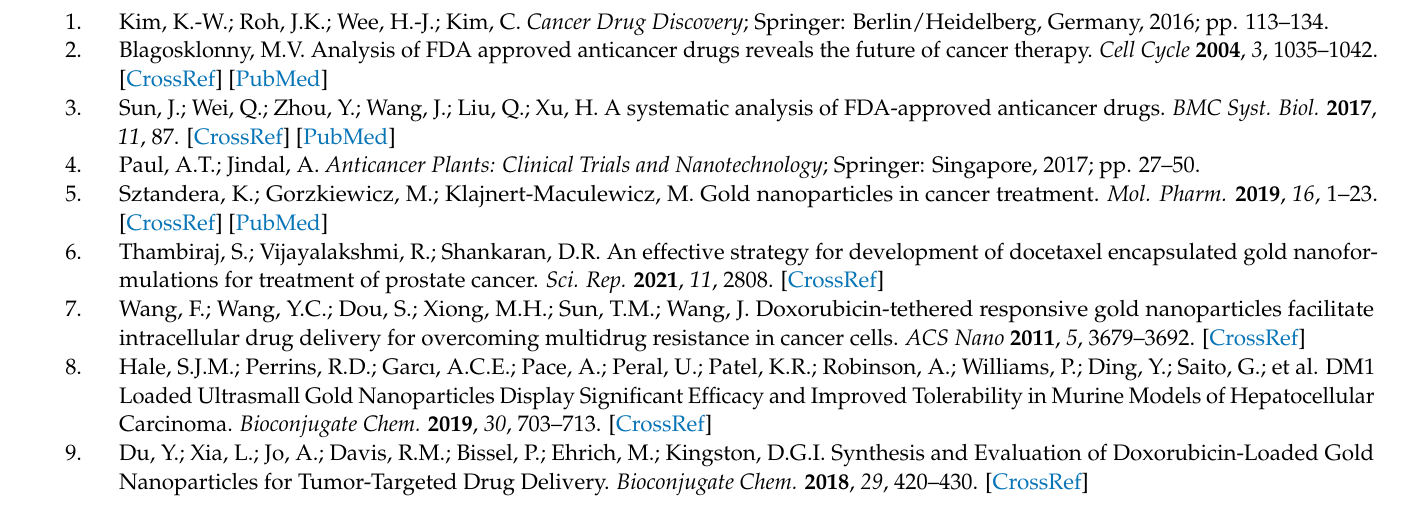
NMR data (DMSO- d 6 , 100 MHz) of Tsitsikammamine B ( 7 , TB) obtained at 298 K. Figure S5. 1 H NMR data (DMSO- d 6 , 400 MHz) of 14-bromodiscorhabdin C ( 5 , BDC) obtained at 298 K. Figure S6. 13 C NMR data (DMSO- d 6 , 100 MHz) of 14-bromodiscorhabdin C ( 5 , BDC) obtained at 298 K. Figure S7. 1 H- 13 C HSQC NMR data (400 MHz, D 2 O) obtained from the S. incisifolium aqueous extract. Figure S8. 1H DOSY spectra (400 MHz) of the S. incisifolium aqueous extract in D 2 O at 25 ◦ C. The values obtained in log(m 2 /s) for the polyphenol, polysaccharides and water signals are given on the spectrum. Figure S9. Typical UV/Visible spectra obtained for the AuNPs (A) synthesized using the S. incisifolium extract (1.0 mg and 20 mg of HAuCl 4 salt), with absorbance spectra collected every 5 min for 4.5 h in water. As the amount of extract increased (B), the AuNPs were produced more efficiently, as revealed by the SPR band at 524 nm. Figure S10. Energy Dispersive Spectroscopy (EDS) spectra for cAuNPs (left) and sAuNPs (right). Figure S11. UV/Visible absorption spectra of the sAuNPs in a variety of NaCl concentrations. Figure S12. HRTEM images obtained for the sAuNPs following incubation with HSA. Figure S13. Reconstituted AuNPs following ultrafiltration- centrifugation. The cAuNPs lost the characteristic pink/purple color, becoming blue on conjugation, centrifugation (through the PES membrane), and freeze-drying, while the sAuNPs retained their color and morphology (please see Figure 2G, main text). Figure S14. IC 50 value determinations for doxorubicin ( 3 ), 14-bromodiscorhabdin C ( 5 ), Tsitsikammamine A ( 6 ) and Tsitsikammamine B ( 7 ) together with the AuNP conjugates (right). Table S1: NMR data of 6 obtained in DMSO- d 6 at 400 MHz at 298 K in comparison to literature values. Table S2: NMR data of 7 obtained in DMSO- d 6 at 400 MHz at 298 K in comparison to literature values. Table S3: NMR spectroscopic of 5 obtained data in DMSO- d 6 at 298 K in comparison to literature